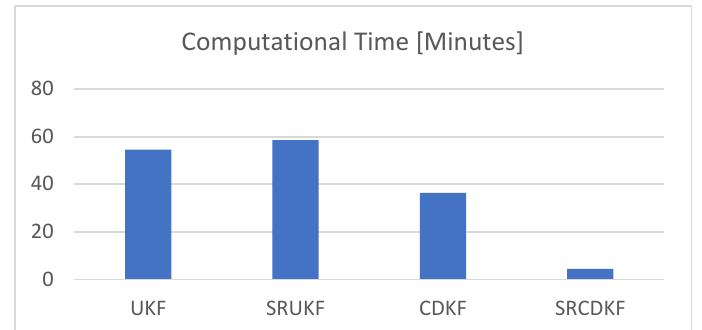
Figure 2. Comparison of computational complexity.